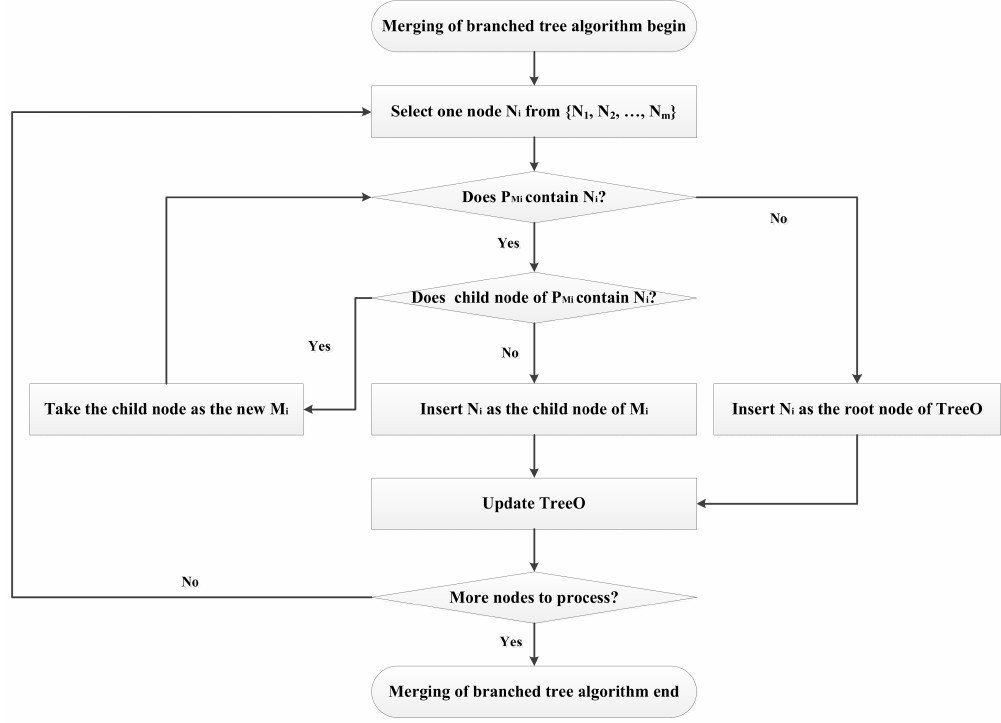
Figure 4. Flow diagram of merging of branched tree